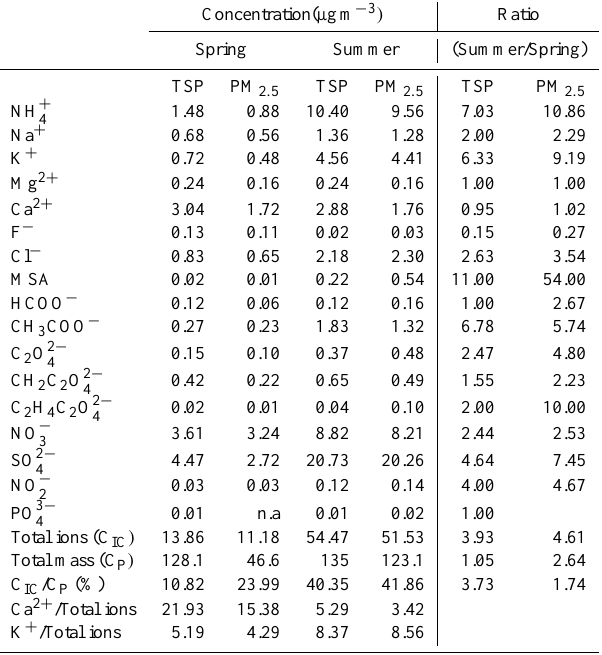
Table 4. Water-soluble ions in PM 2 . 5 and TSP and the correspond- ing ratios of summer/spring at